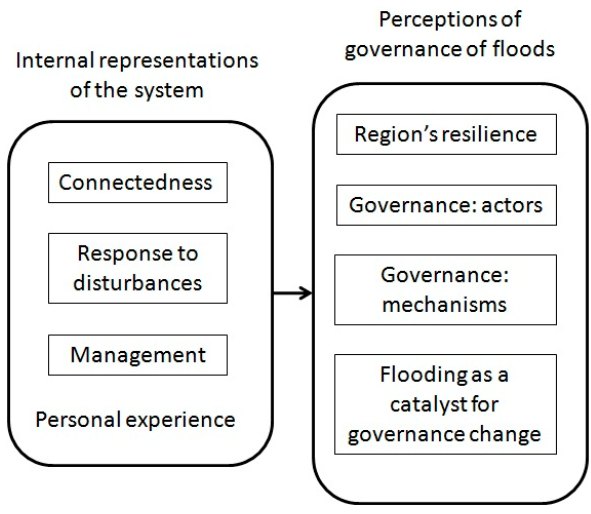
Figure 1. Framework for analysis.